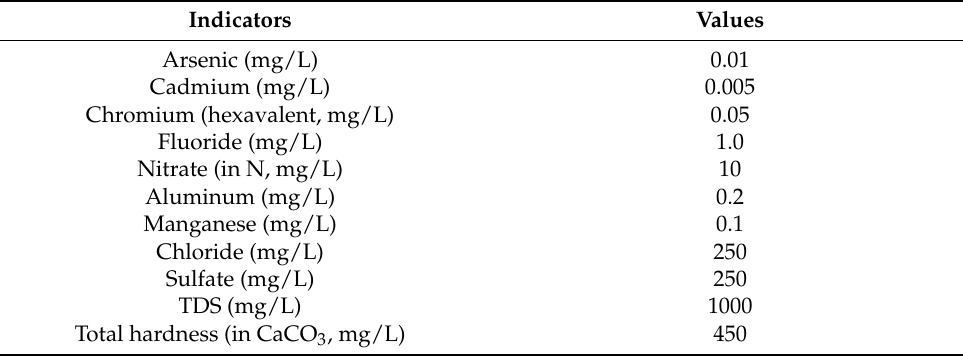
Table 1. Indicators for drinking water quality established by